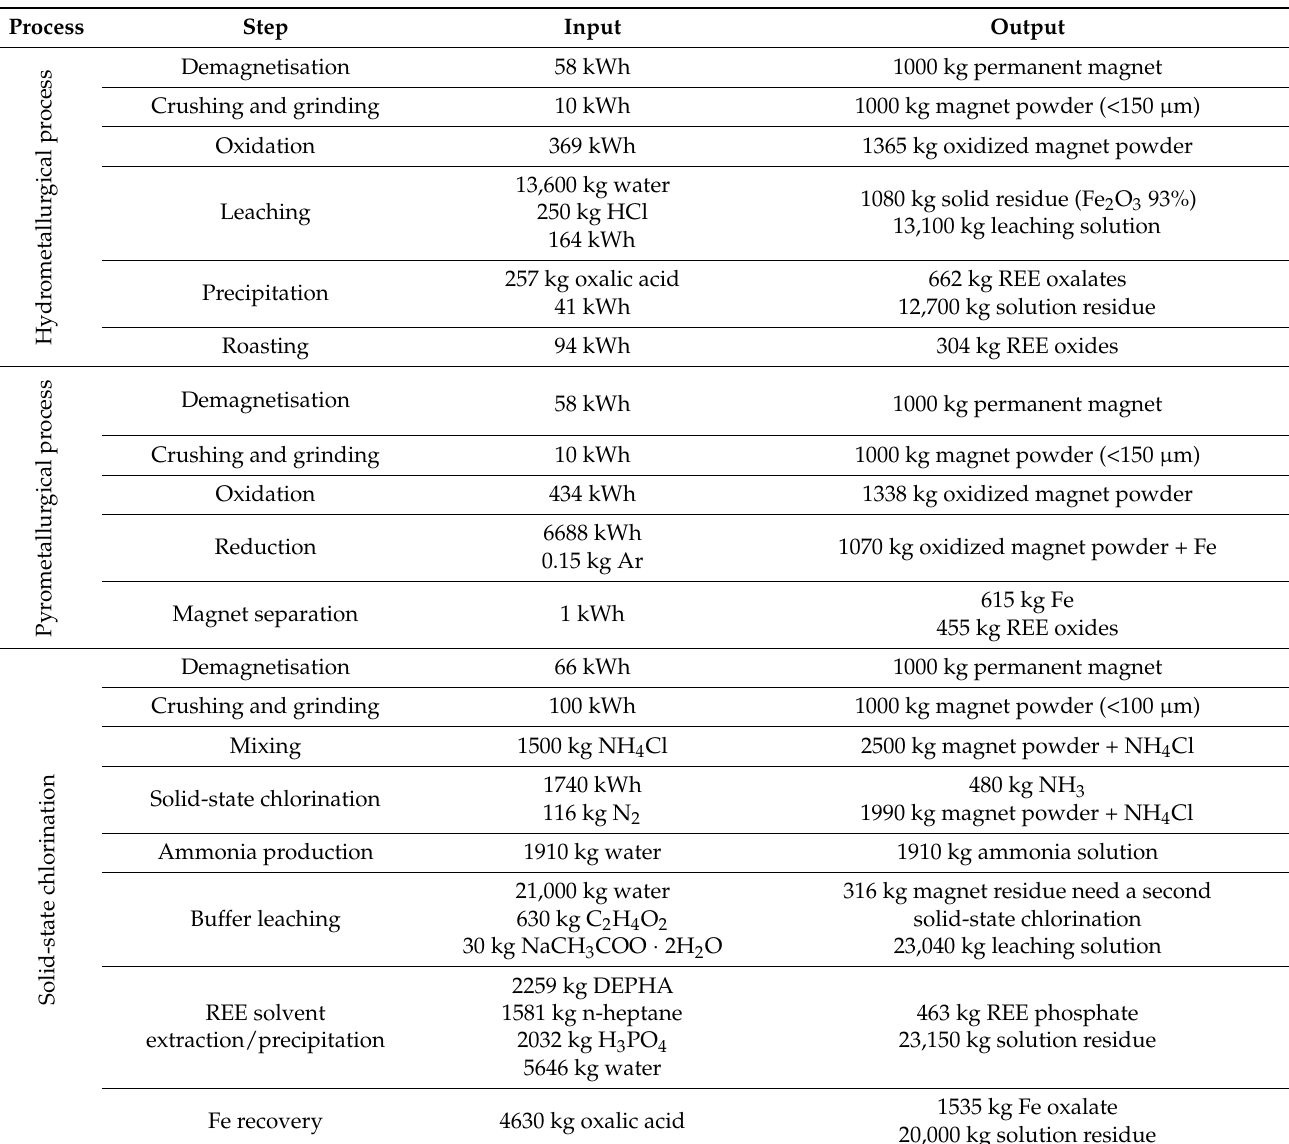
Table 1. Energy and mass balance of the three considered treatment for the end-of-life permanent magnet exploitation.